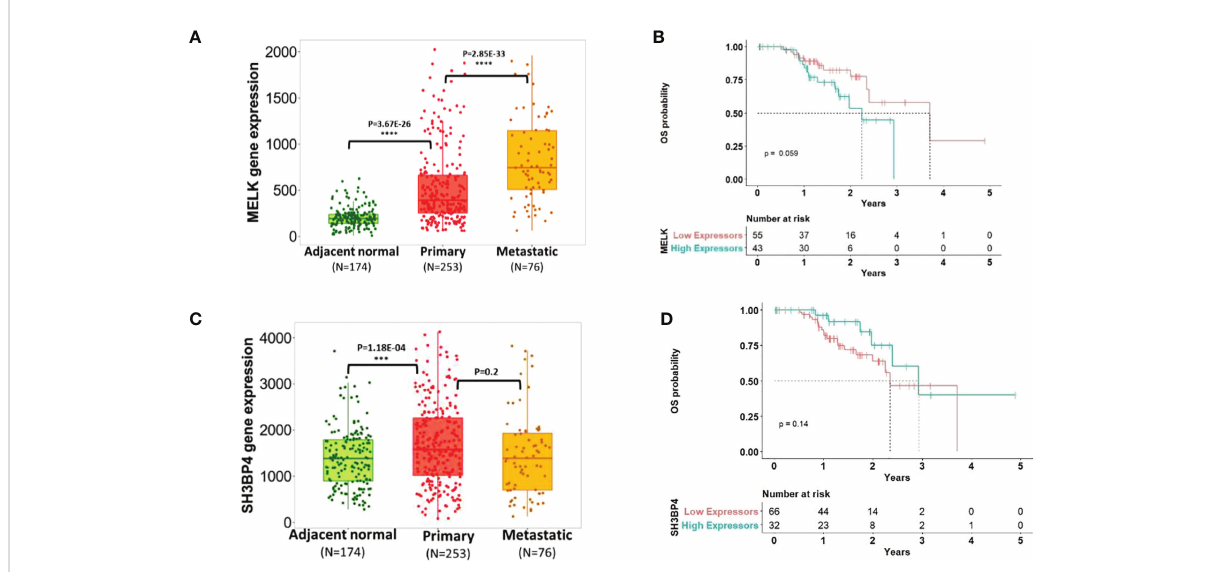
FIGURE 2 Transcriptomic pro fi ling of the candidate gene expressions and melanoma progression. Panel (A+C) showed the expression of MELK and SH3BP4 comparing adjacent normal vs. primary vs. metastatic tumor tissues [adapted from tnmplot.com (45)]. Panel (B+D) plotted Kaplan-Meir survival curves [adapted from the Human Protein Atlas (46)] of early-stage CM patients with low vs. high expression of MELK and SH3BP4 in primary tumors. High expression of MELK was associated with worse OS (log-rank p=0.059), while the inverse trend was observed for SH3BP4 (albeit not statistically signi fi cant p=0.14), re fl ecting their roles as an oncogene and a tumor suppressor,